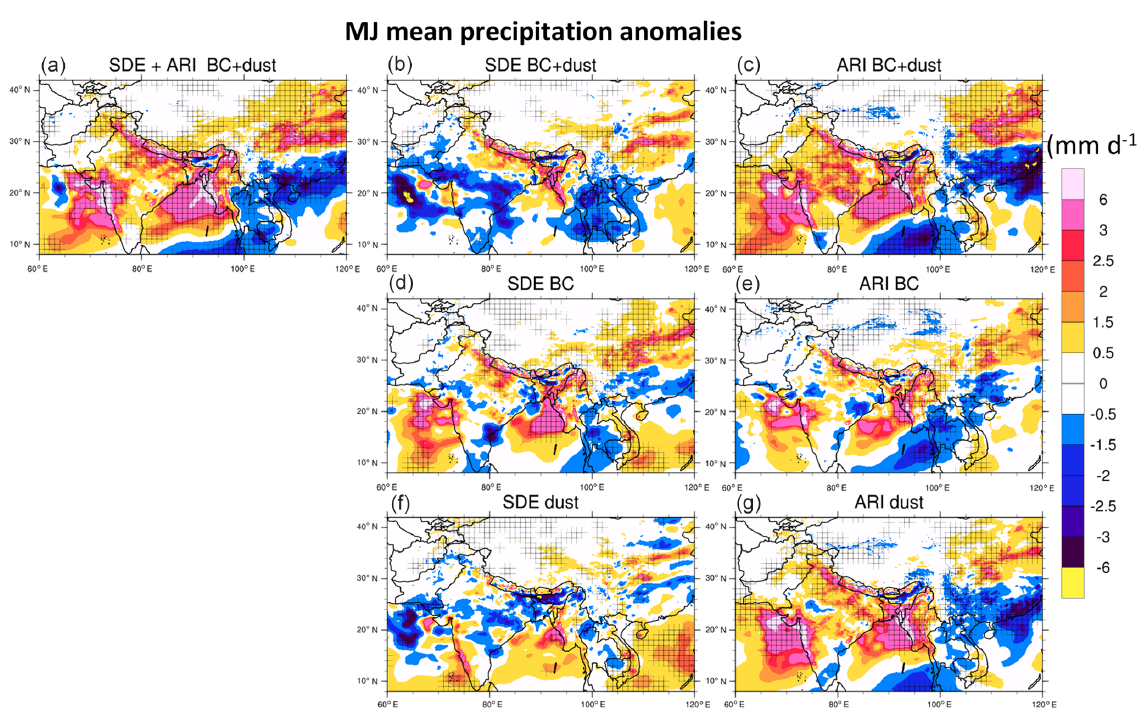
Figure 11. Same as in Fig. 6, but for precipitation rate (mmd − 1 ).